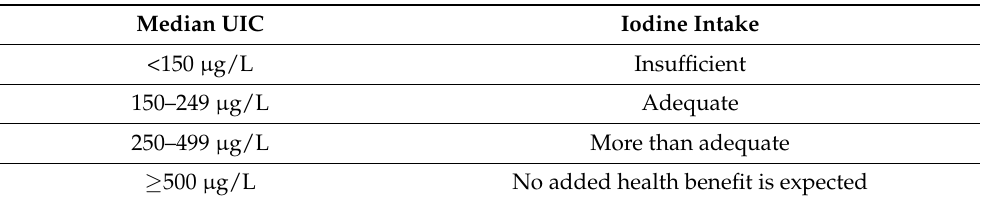
Table 2. Assessment of iodine assumption in pregnant women based on median urinary iodine concentrations (UICs). Adapted from [16].